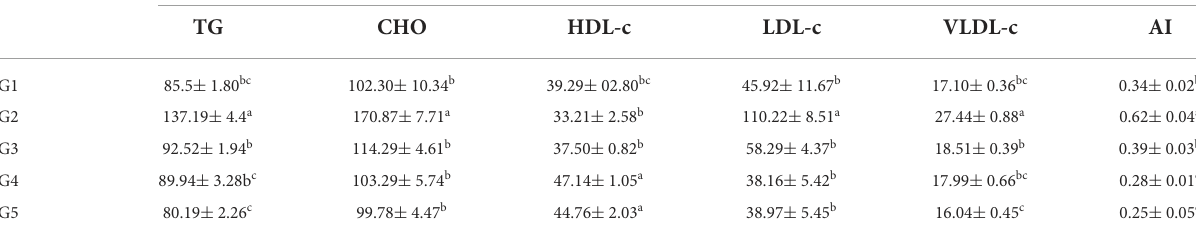
TABLE 4 Effect of hydroalcoholic extract of L. culinaris sprouts on lipid profile and Atherogenic index in CCl 4 -induced oxidative stress and hepatotoxicity in rats (mean ± SE), n = 8. Groups